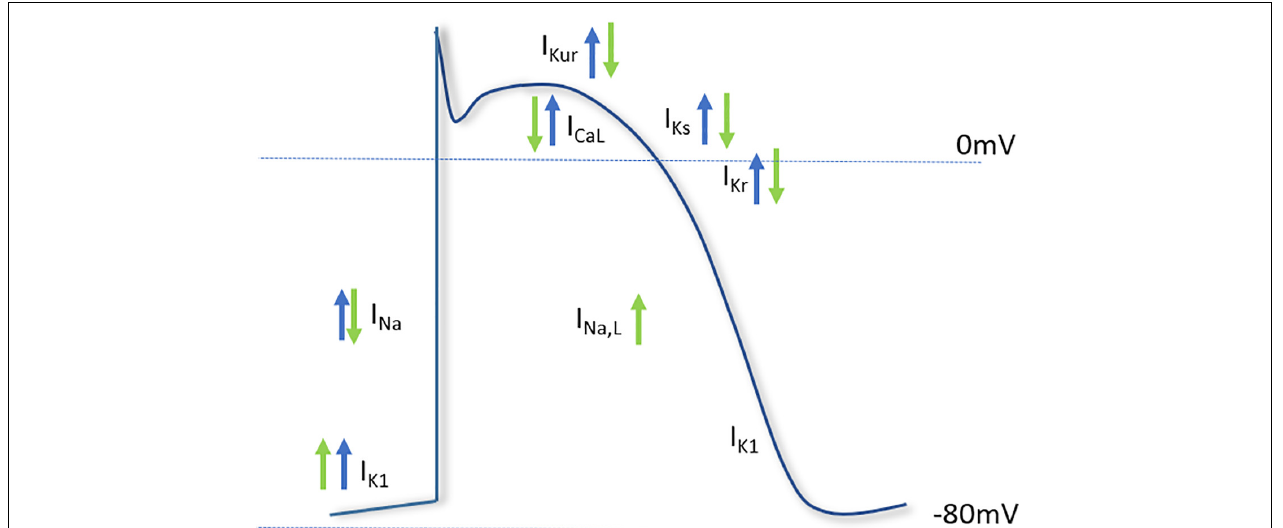
FIGURE 4 | Major cardiac ion channels known to be affected by nitric oxide and mechanical stimuli. The effect of nitric oxide (green arrows) and mechanical stress (blue arrows) on the major currents of the cardiac action potential. The depolarizing sodium current (I Na ), responsible for the upstroke of the action potential, is increased by mechanical stress and decreased by NO. The late component of I Na is increased by NO. The L-type calcium current (I CaL ), involved in the plateau phase of the action potential, is inhibited by NO, but increased by mechanical stress. Of the repolarizing potassium currents, NO inhibits the ultrarapid delayed rectifier current (I Kur ), the rapid delayed rectifier (I Kr ) and slow delayed rectifier (I Ks ), whereas the inwardly rectifying potassium current (I K 1 ) is increased by NO. Mechanical stress has been shown to activate the repolarizing currents I Kur , I Ks , I Kr , and I K 1